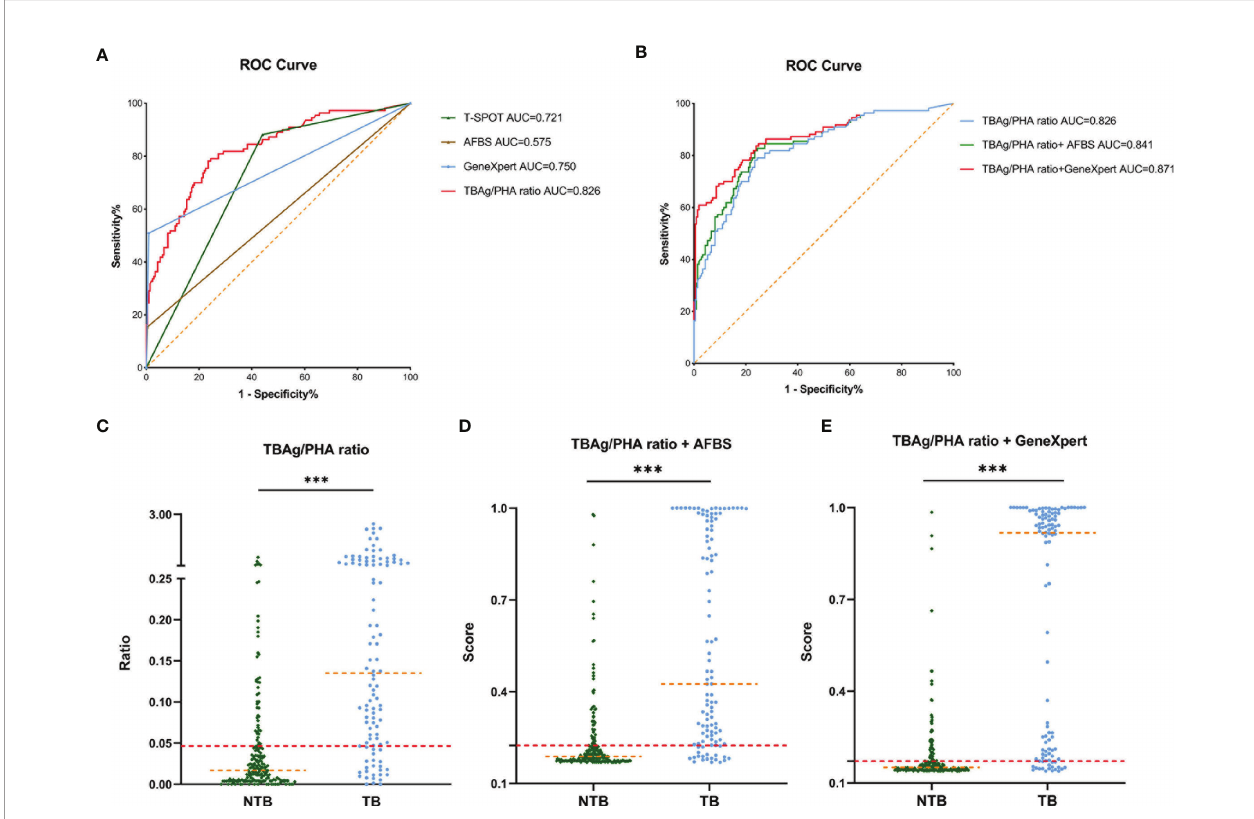
FIGURE 2 | ROC curve of different tuberculosis tests and establishment of a diagnostic model in the Tongji Hospital cohort. (A) ROC analysis showing the performance of T-SPOT, AFBS, GeneXpert MTB/RIF, and TBAg/PHA ratio. (B) ROC analysis displaying models for the diagnosis of spinal tuberculosis based on the TBAg/PHA ratio or in combination with AFBS or GeneXpert MTB/RIF. (C) Scatter plots showing the ratio of TBAg/PHA in spinal tuberculosis patients (n = 110) and no spinal tuberculosis patients (n = 209). Orange dotted lines representing the median value. Red dotted lines indicating the cutoff value in distinguishing these two groups. ***p < 0.001 (Mann – Whitney U-test). (D) Scatter plots showing the score of the diagnostic model based on TBAg/PHA ratio combined with AFBS in spinal tuberculosis patients (n = 110) and no spinal tuberculosis patients (n = 209). Orange dotted lines representing the median. Red dotted lines indicating the cutoff value in distinguishing these two groups. ***p < 0.001 (Mann – Whitney U-test). (E) Scatter plots showing the score of the diagnostic model based on TBAg/PHA ratio combined with GeneXpert MTB/RIF in spinal tuberculosis patients (n = 110) and no spinal tuberculosis patients (n = 209). Orange dotted lines representing the median. Red dotted lines indicating the cutoff value in distinguishing these two groups. ***p < 0.001 (Mann – Whitney U-test). ROC, receiver operating characteristic; AUC, area under the curve; AFBS, acid-fast bacilli smear; MTB, Mycobacterium tuberculosis ; RIF, rifampicin resistance; TBAg, Mycobacterium tuberculosis -speci fi c antigen; PHA,